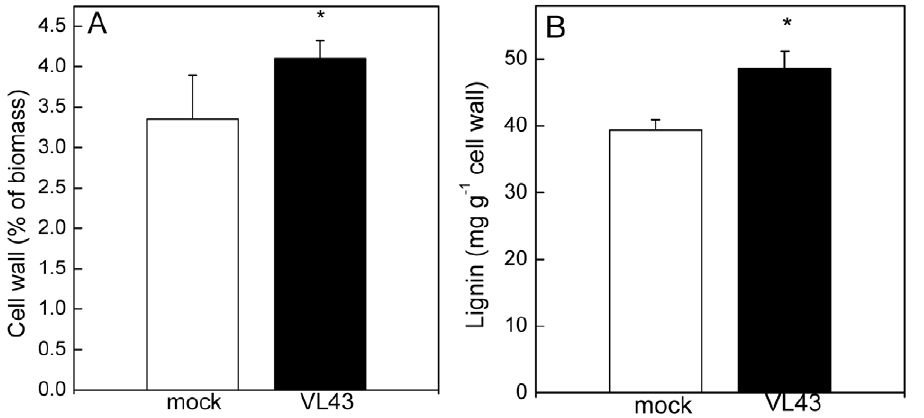
Figure 4. Influence of Verticilliumlongisporum (VL43) on the amount of cell wall material and lignin in mock and VL-infected leaves of Arabidopsisthaliana . Data indicate means (n=9, 6 SE). *indicate significant differences between mock and VL-infected plants.